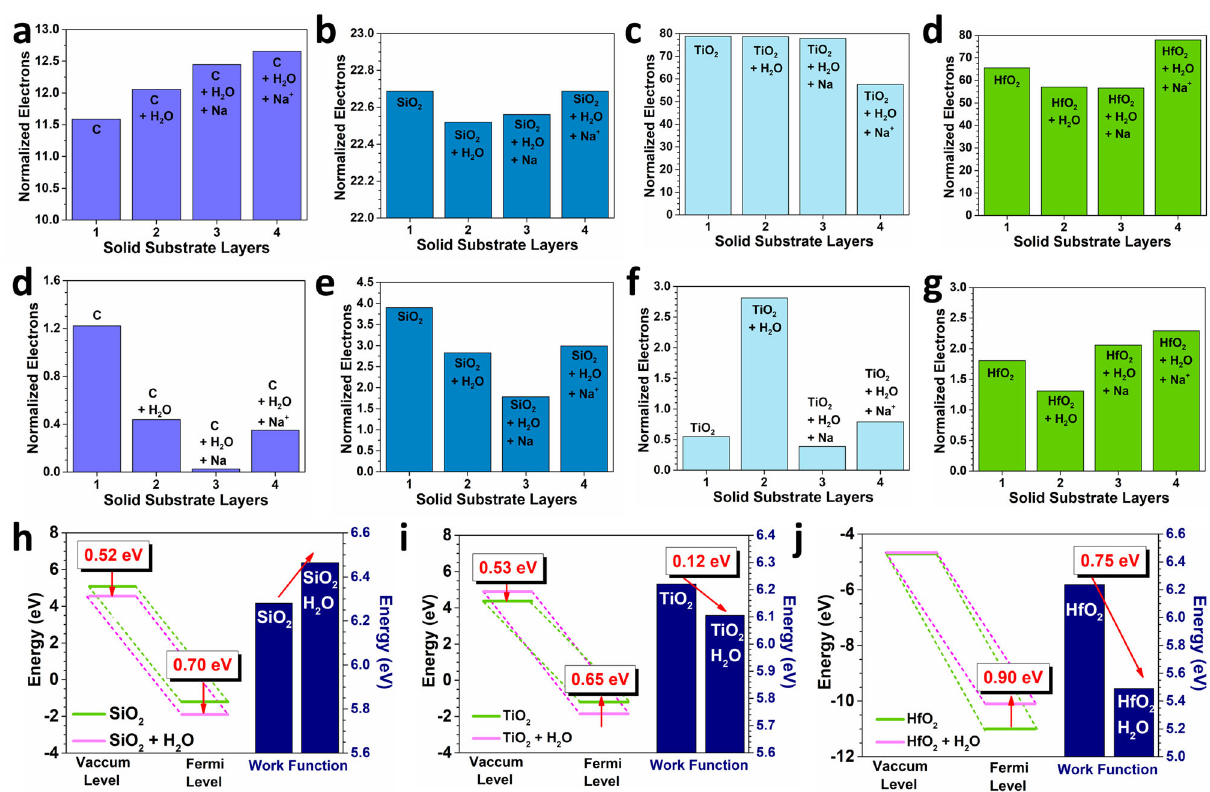
Fig. 2 The normalized electron numbers of the valence band for different solids in contact with water and solution. a Diamond carbon, b SiO 2 , c TiO 2 , and d HfO 2 . The normalized electron numbers near the Fermi level for different solids in contact with water and solution. d Diamond carbon, e SiO 2 , f TiO 2 , and g HfO 2 . h The comparison of vacuum level, Fermi level change, and work functions after contacting with water. h SiO 2 , i TiO 2 , and j HfO 2